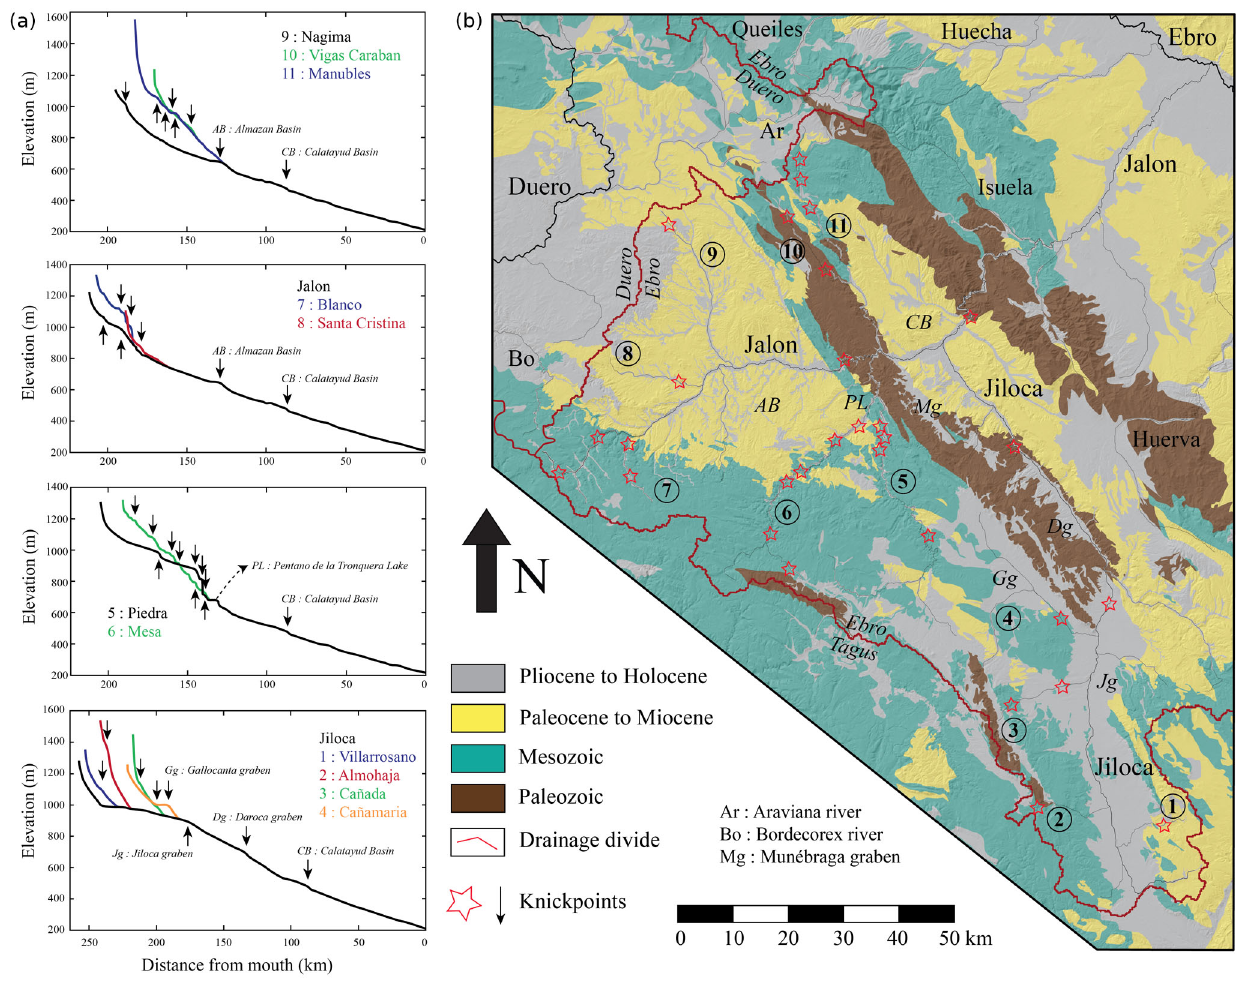
Figure 4. Zoom of the geological map of the Iberian Range showing the location of the Jalón River tributaries. The river long profiles of these streams and the location of knickpoints are shown to the